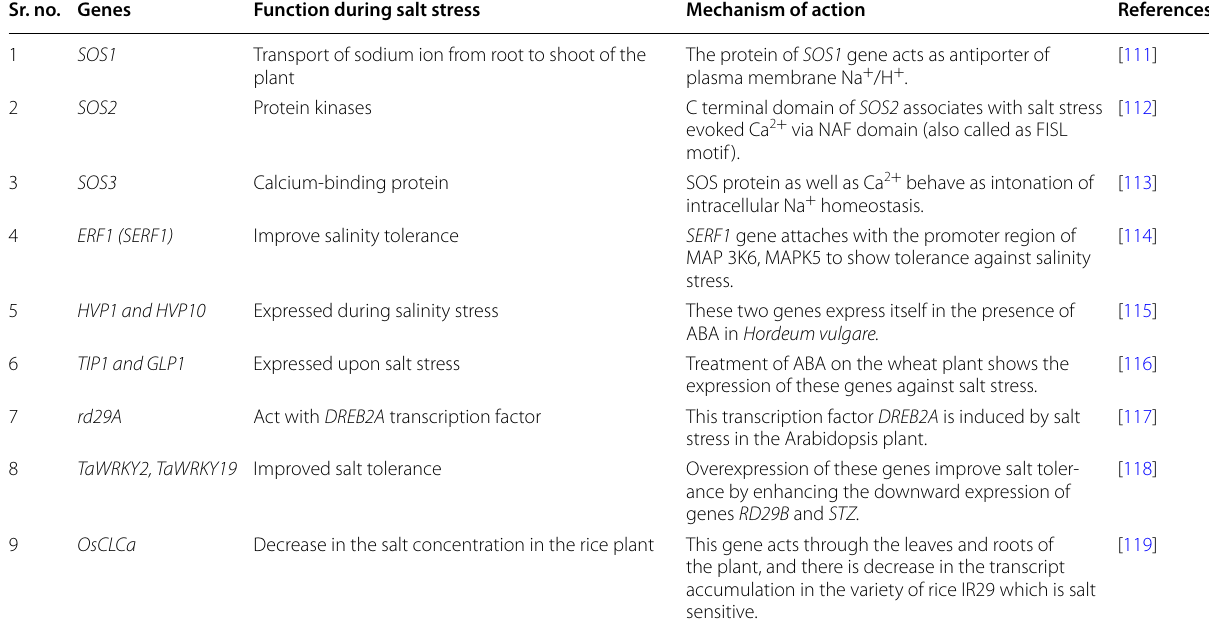
Abbreviations used: SOS1 salt overly sensitive 1, SOS2 salt overly sensitive 2, SOS3 salt overly sensitive 3, ETF1 ethylene response factor1, HVP hordium vulgare vacuolar H -pyrophosphatase, GLP-1 glucagon-like peptide-1, TIP-1 tip elongation protein 1, Rd29A response-to-dehydration 29A, OsCLCa Oryza sative chloride channel-a, + TaWRKY transgenic tobacco WRKY